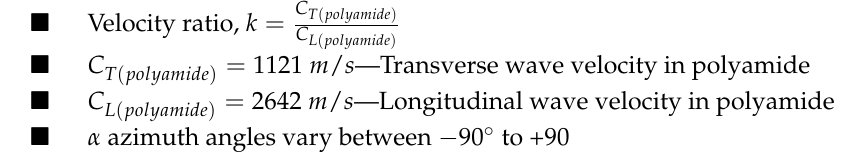
Figure 7. ( a ) Polarization along the test plane, ( b ) polarization perpendicular to the test plane.